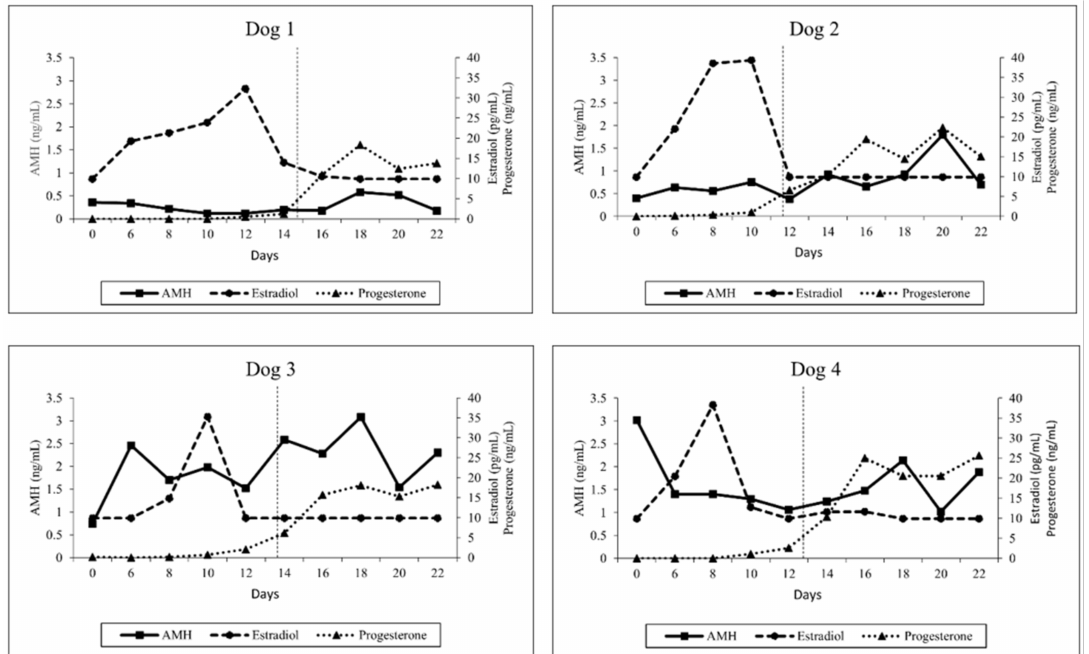
Figure 2. Individual serum progesterone, estradiol and AMH concentrations of four dogs from day 0 to day 22 following treatment with a 4.7 mg deslorelin implant. The vertical dashed line indicates ovulation